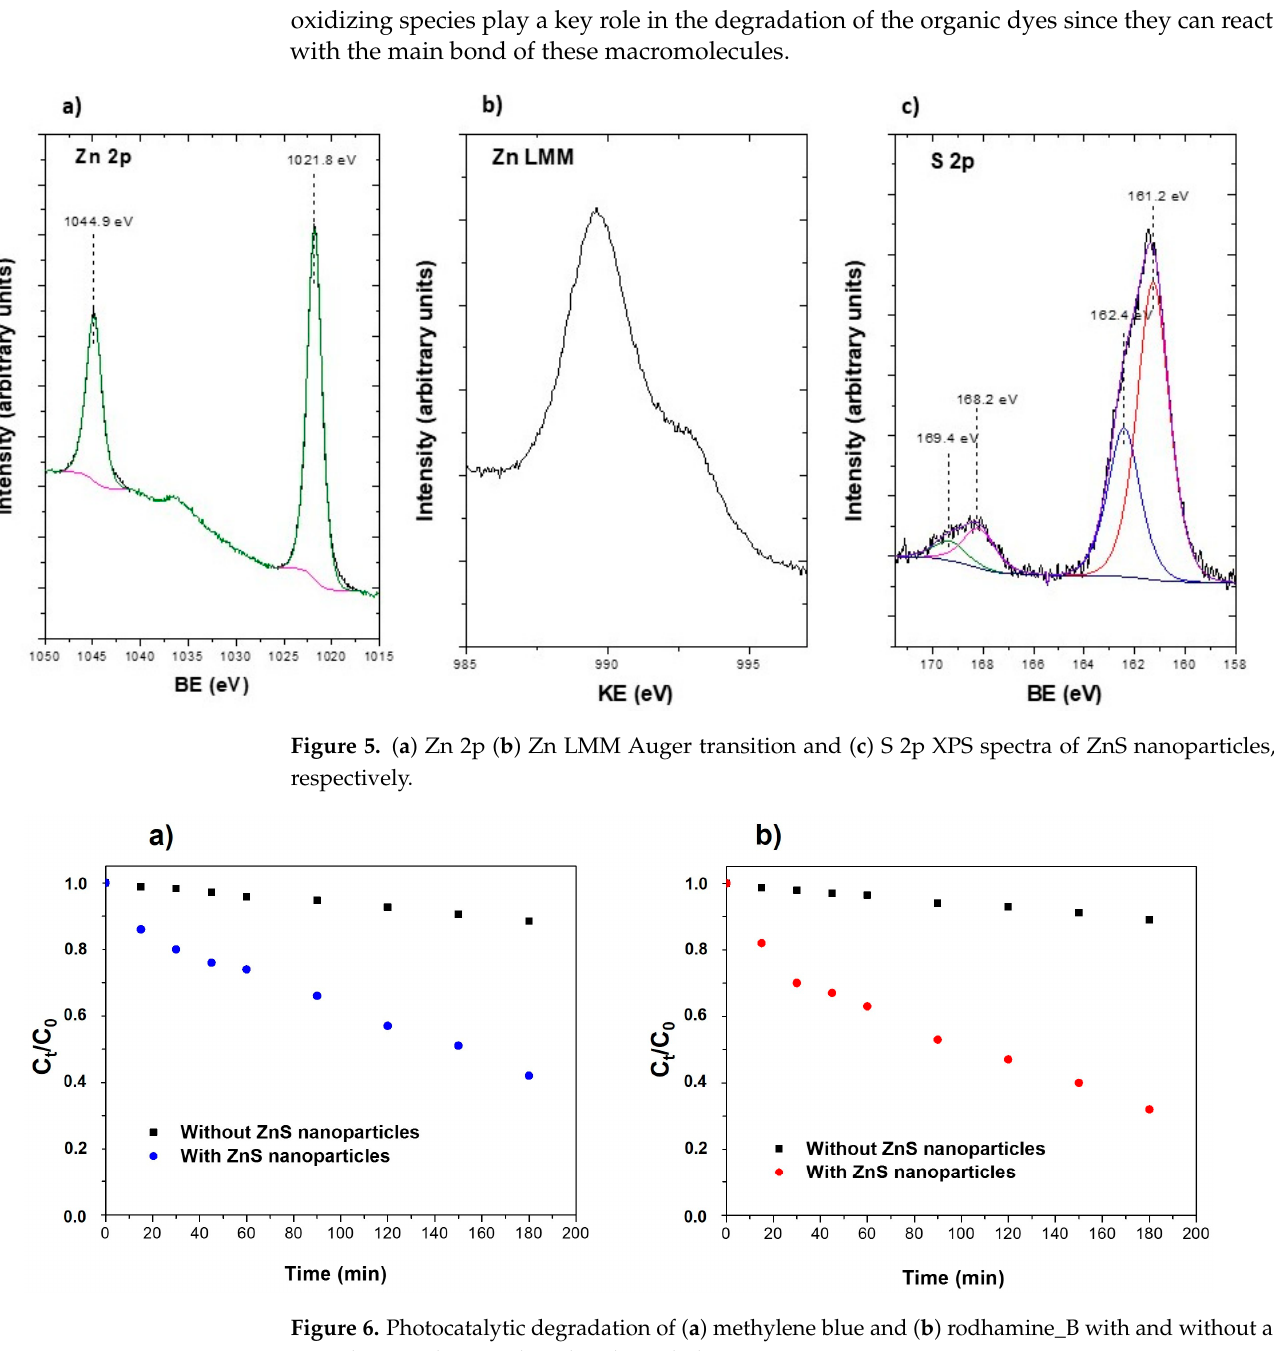
Figure 7. Effects of scavenger on MB and RhB photodegradation by ZnS nanoparticles.